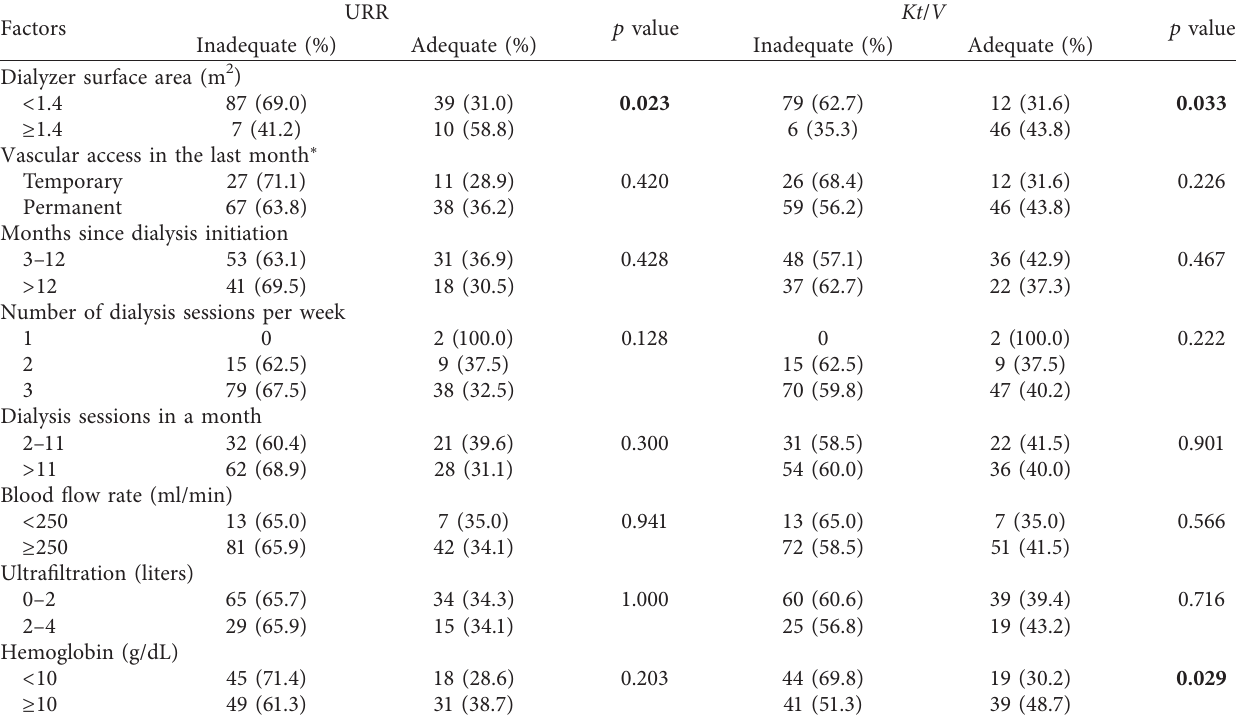
Table 3: Treatment characteristics associated with inadequate hemodialysis.